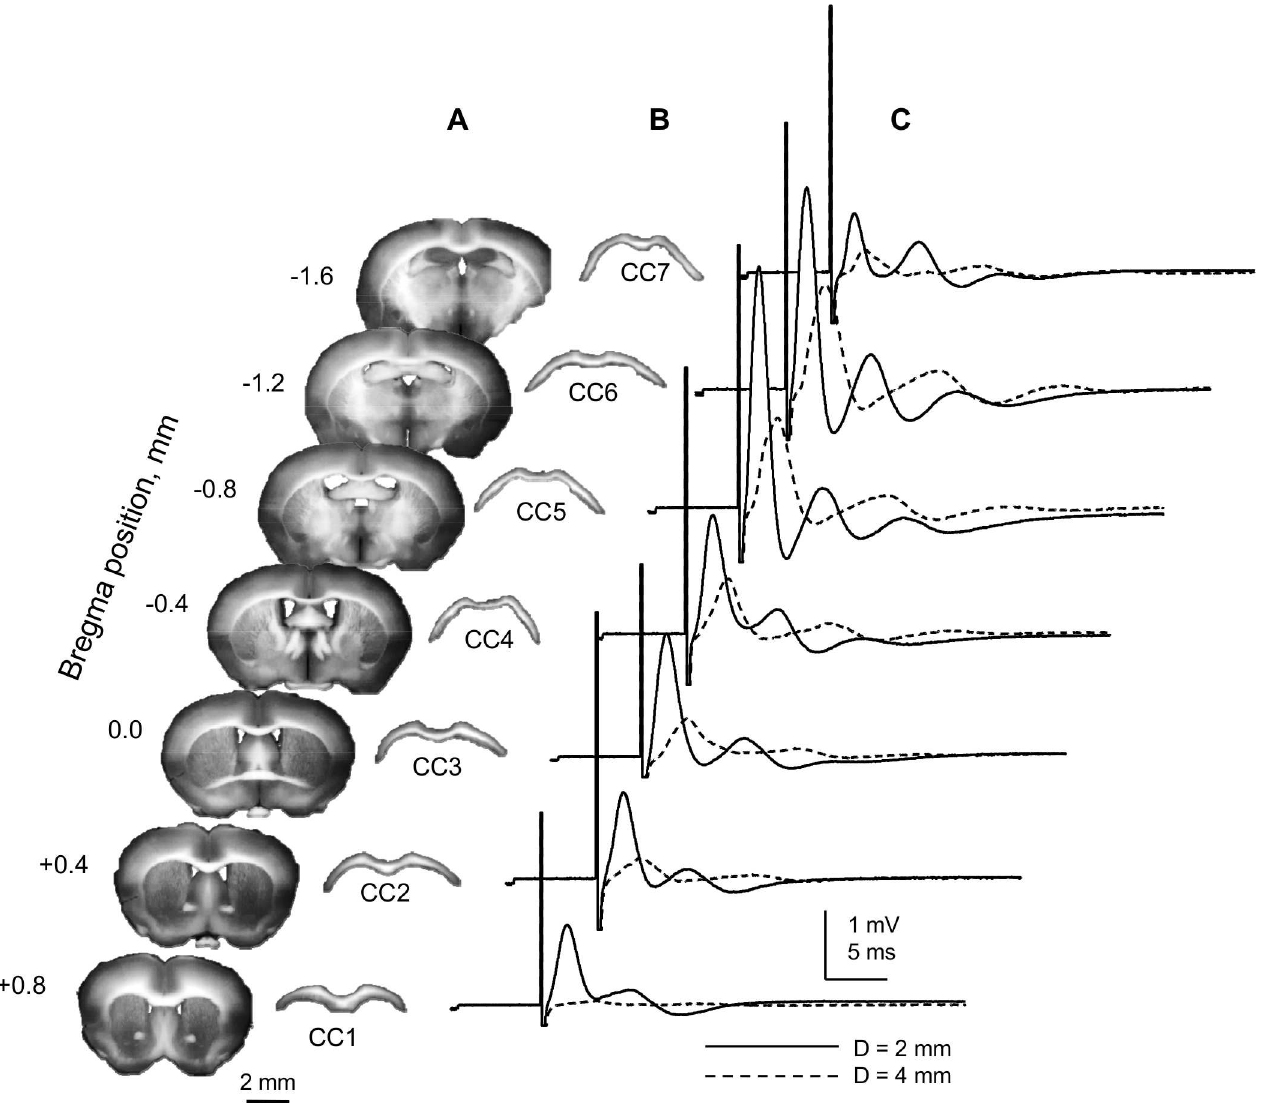
Fig 3. Rostro-caudal patterns of “whole” CC CAPs compound action potentials. (A) Seven consecutive400 μ m-thickcoronal slices from a singlemouse brain. (B) CCs isolated from slices shown on (A). The rostral-most coronal slice was the first from rostral end of the brain where the CC had a continuousappearanceacross the midline,and its corresponding isolated CC is referred to hereafter as CC1. The rostro-caudal position of the slice from which CC3 was isolated corresponds approximately to bregma 0, identified by the presenceof anterior commissure in the lower part of the slice, continuously runningacross the midline. (C) Suction electrode (SE) recordingsfrom CCs shownin (B). Maximal CAPs from each CC, recordedat 4 mm (dashedtraces) and 2 mm (solid traces) conductiondistance. The recordingsstarted at 4 mm, followedby drawingthe CCs deeperinto the SE’s to reach a 2 mm conductiondistance, whilekeepingthe arrangement symmetrical aroundthe CC mid-point. The smaller amplitudeof CAPs recordedat 4 mm distancelikely reflects a lower number of axons in continuitybetweenthe stimulated and recordingsites, in agreement with decreasedCAP areas. Each trace representsan averageof 6 consecutive recordingstaken at 10 s intervals. All recordingsshown here were done at room temperature.